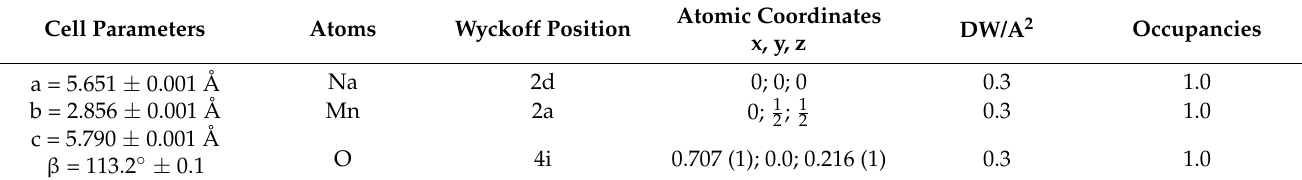
Table 1. Crystal structure parameters refined by Rietveld optimization for the α -NaMnO 2 sample (Space group: C2/m; R wp = 8.512%, G.o.f. = 1.62). Errors on the last digit of the optimized atomic positions (cell axes fractions) are reported in